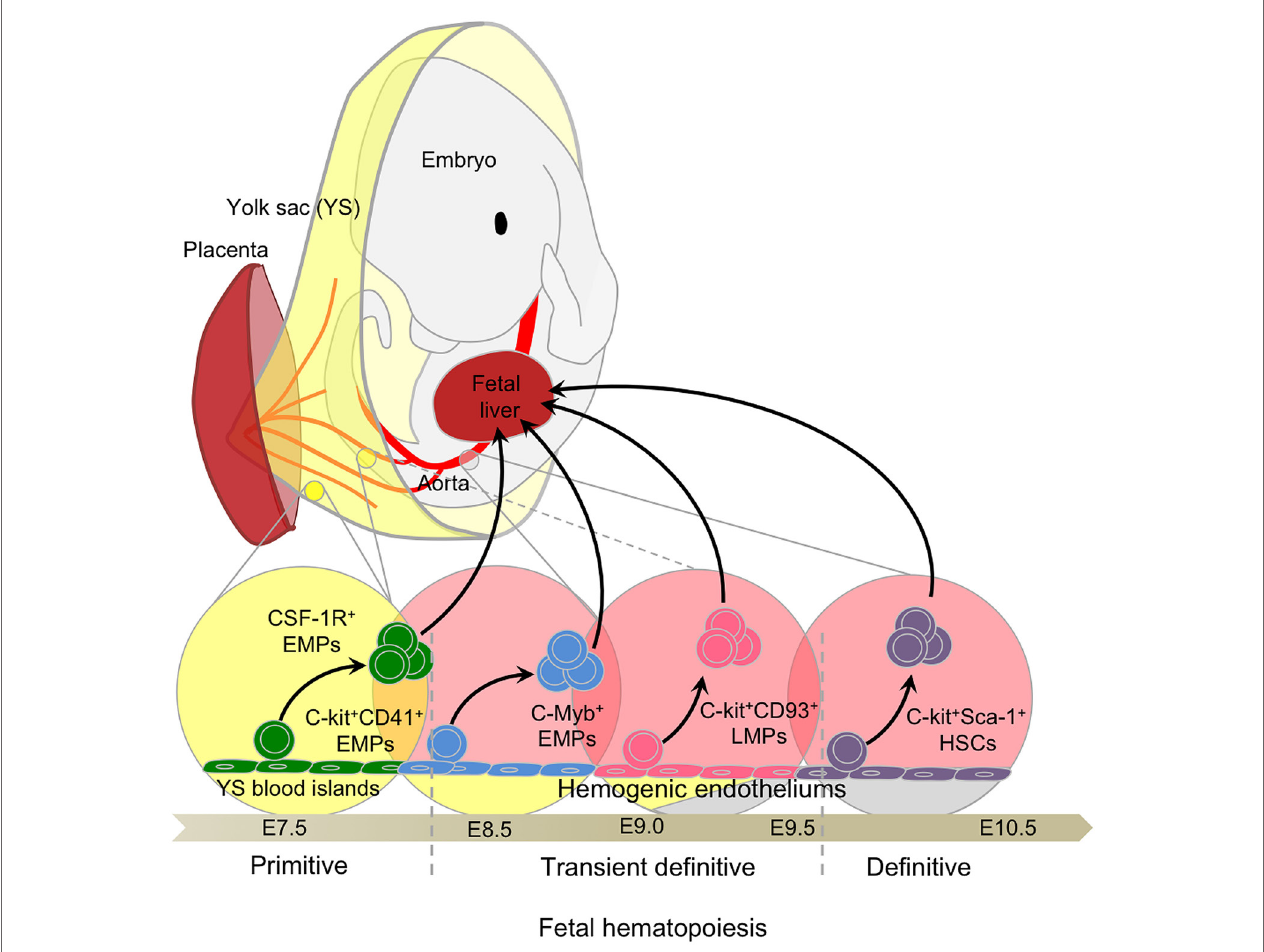
FiGURe 1 | Fetal hematopoiesis . Primitive, transient definitive, and definitive waves of fetal hematopoiesis sequentially generate progenitors able to seed the fetal liver. Primitive hematopoiesis starts at E7.0 in the blood islands of the extra-embryonic yolk sac (YS) and generates erythro-myeloid progenitors (EMPs). Early EMPs initially express CD41 and later, CSF-1R, a signature of myeloid/macrophage commitment. Concomitant to the establishment of the blood circulation at E8.5, the YS hemogenic endothelium (HE) generates late EMPs expressing C-Myb. At approximately E9.0, the intra-embryonic mesoderm generates additional HE and emerging progenitors with lymphoid potentials (LMPs) without long-term reconstitution (LTR) capacity. These C-Myb + EMPs and LMPs constitute the so-called transient definitive wave. Finally, hematopoietic stem cells (HSCs) with LTR activity emerge from the main HE situated in the aorta-gonad-mesonephros (AGM) regions and in the